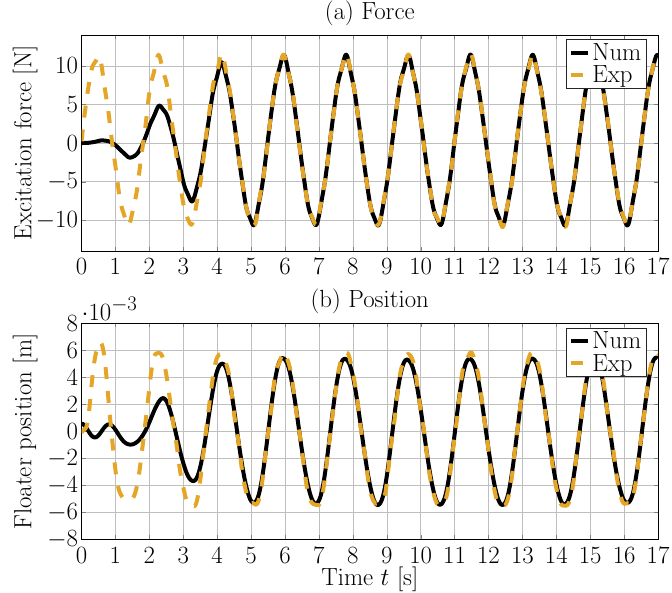
Figure 16. Time trace of the single-frequency (0.54 Hz) excitation force ( a ) and the floater position ( b